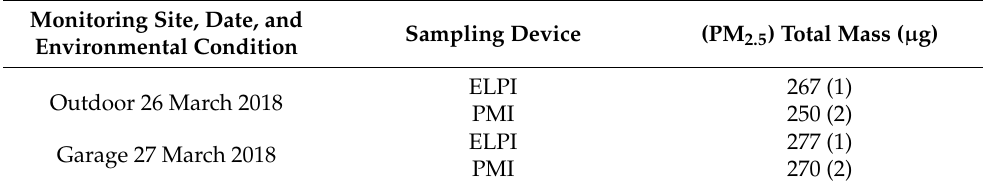
Table 2. PM 2.5 total mass (expressed in µ g) calculated for the ELPI+ andPMI. Relative percent errors (%) are reported in round